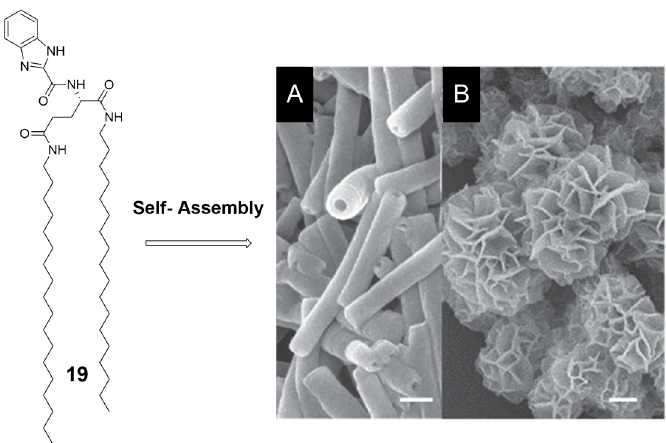
Figure 16. Molecular structure of 19 and fabrication of hierarchical chiral nanostructures, which was based on the self-assembly of 3 and regulated by solvents and metal ions: ( A ) nanotubes (scale bar = 100 nm); and ( B ) flower-like structures (scale bar = 1 μ m). Partially reproduced with permission from Ref. [73] (Copyright Wiley-VCH, 2016).